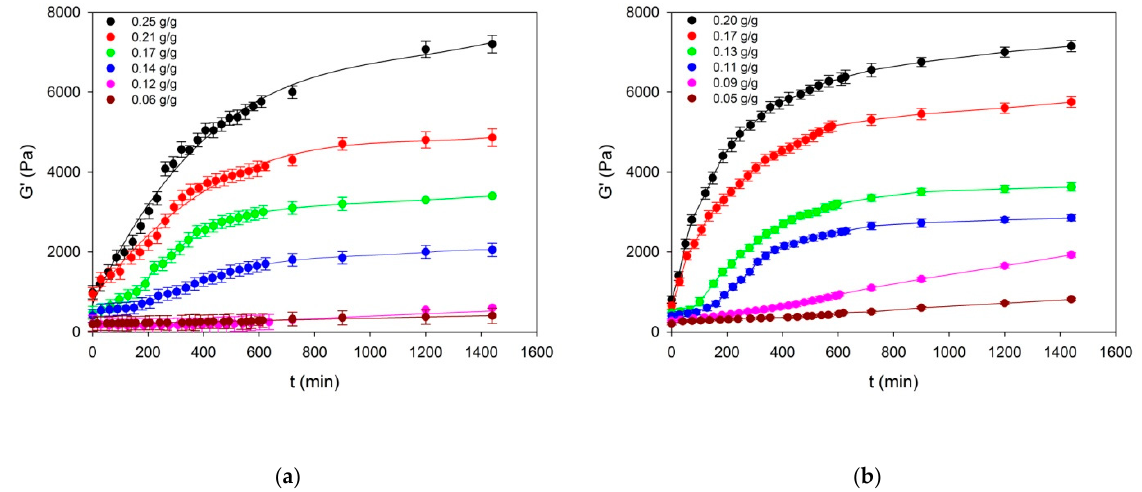
Figure 1. Kinetics of the storage modulus ( G’ ) in the process of formation of starch gels ( a ) and starch–fat emulsions ( b ). The values are expressed as means ± SD ( n = 3).